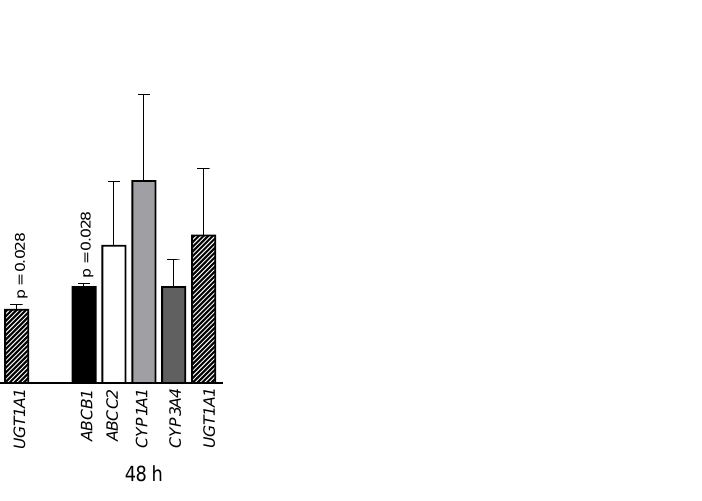
Figure 3. mRNA expression levels of selected drug disposition genes in LS180 cells after treatment with 5000 U/mL IFN- α 2a for 24 h or 48 h. mRNA expression levels of exposed samples were normalized to expression levels of untreated control samples. Data shown are the mean ± S.E.M. of four independent experiments with technical duplicates for each compound, gene, or time point, respectively. Significant differences between drug-treated samples and corresponding controls were evaluated by an unpaired, nonparametric, two-sided Mann – Whitney U-test. p values < 0.05 were con-